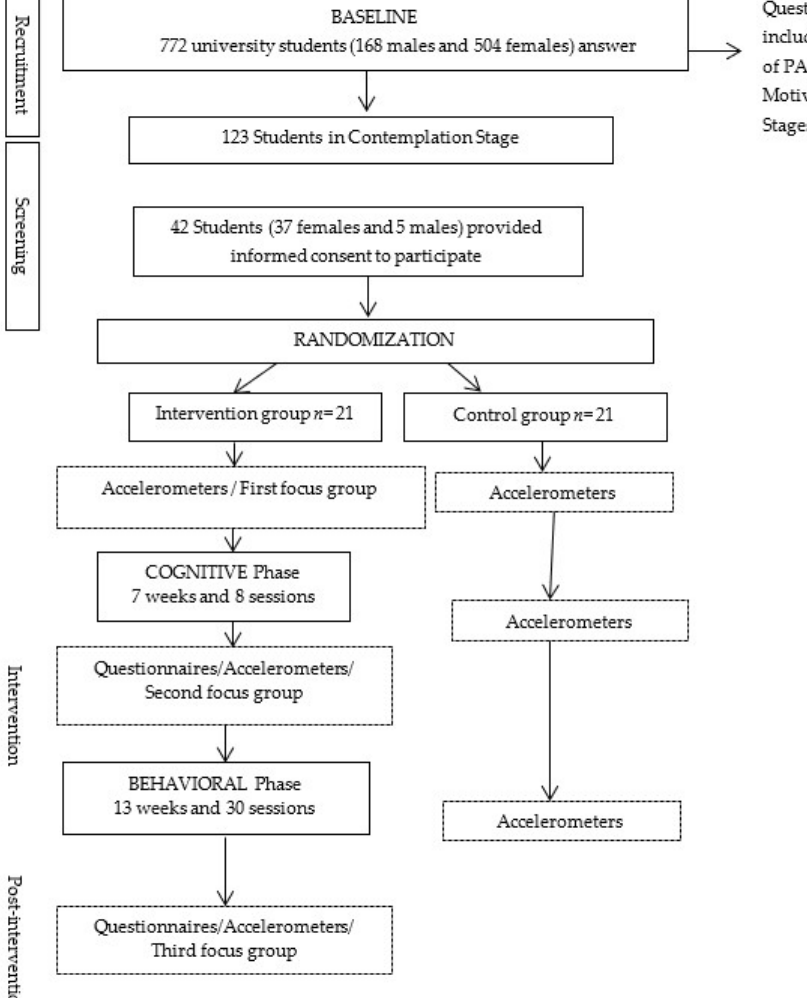
Figure 1. Flowofparticipantsandstudydesign. Abbreviations: Physicalactivity(PA);BasicPsychological Needs